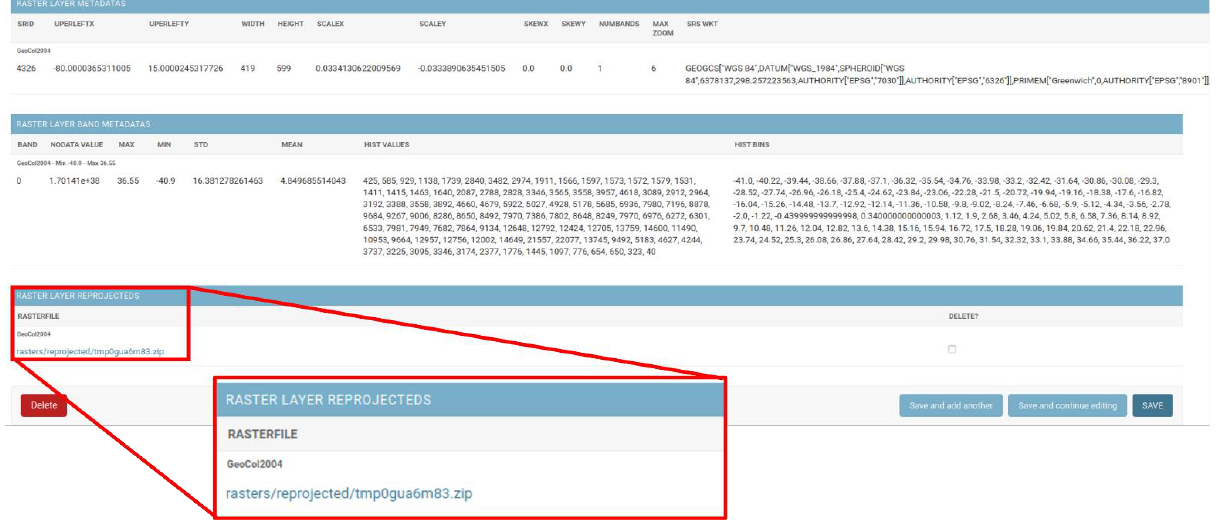
Figure 6. Geoid Model – Save product into DBMS – Add product